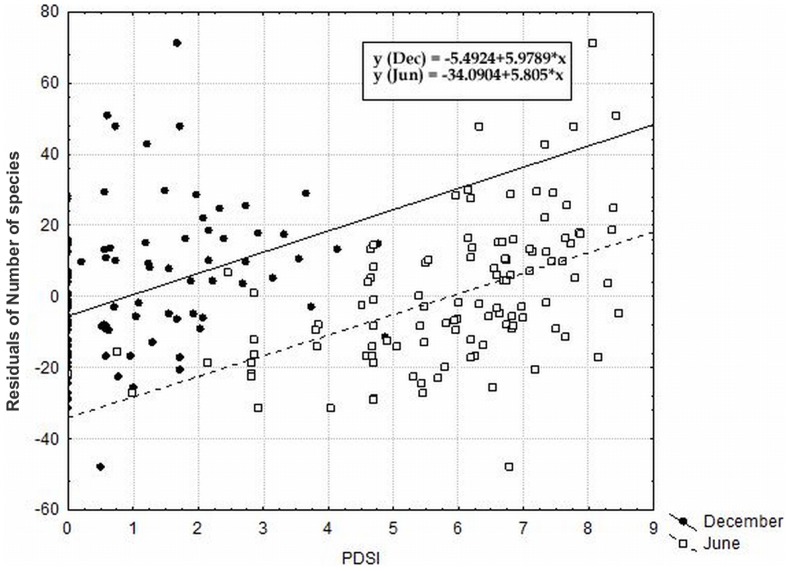
The effect of PDSI on species richness.The effect of potential direct solar insolation (PDSI) on December 21st and June 21st on species richness (depicted as residuals of number of species with coordinates as covariates). P<0.0001; r = 0.360 for December and p<0.0001; r = 0.510 for June.